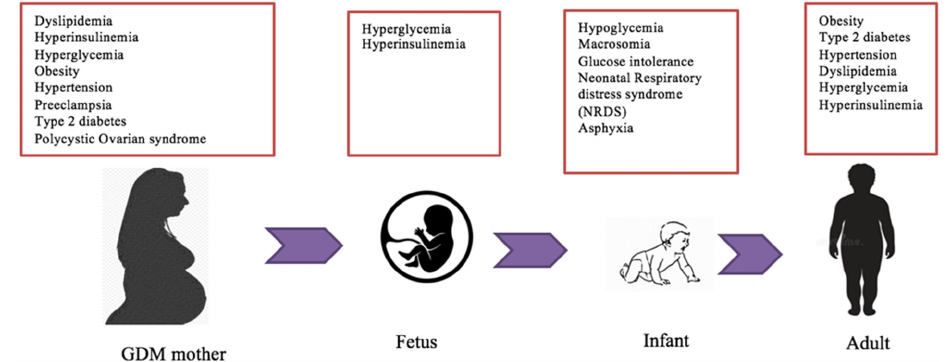
Figure 1. Metabolic complications associated with GDM. Several metabolic risks link maternal GDM to fetal and neonatal health outcomes in utero. These obstetrical comorbidities influence fetal growth and development from embryogenesis to offspring adulthood and are mostly caused by dysfunction in glucose, insulin, and lipid pathways. The majority of these clinical conditions in GDM mothers are developed and persistent in the offspring later in life.